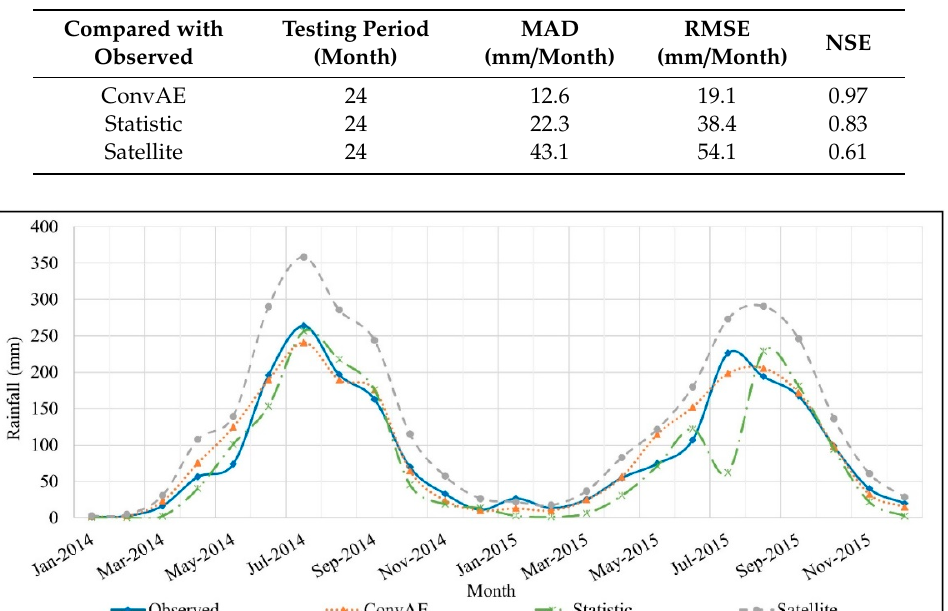
Table 3. Temporal correlation of the monthly total precipitation between the corrected products and observed data during the testing period. MAD: mean absolute di ff erence, RMSE: root mean square error, and NSE: Nash–Sutcli ff e e ffi ciency.